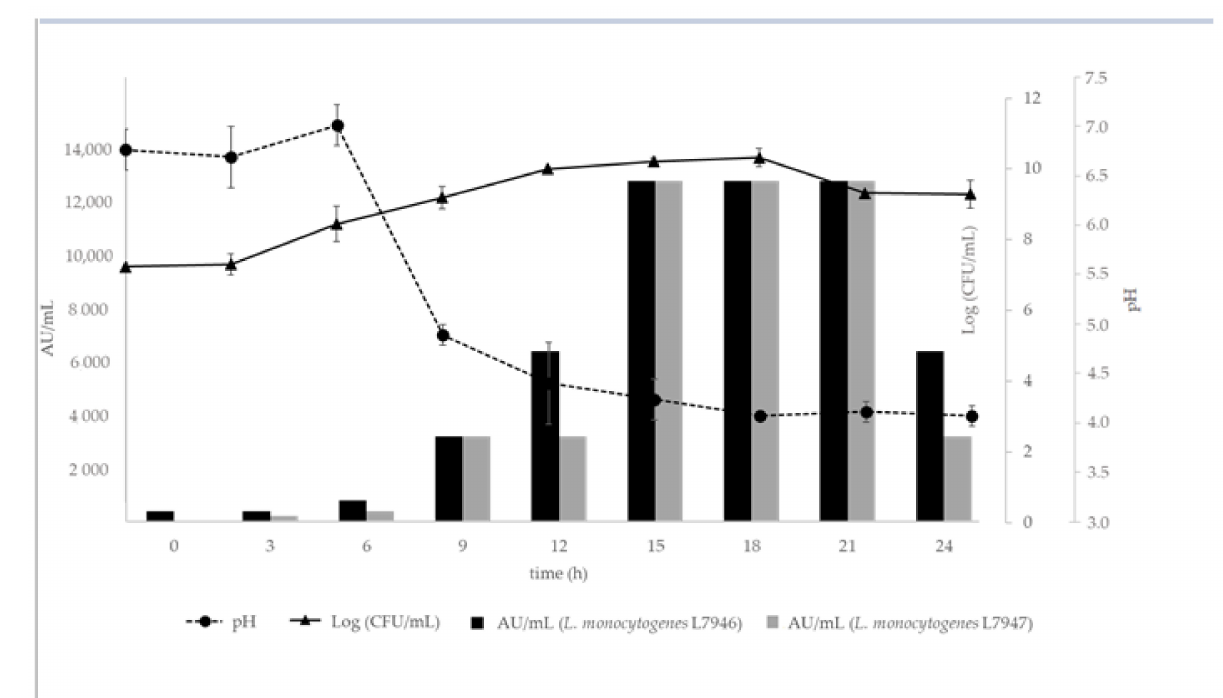
Figure 2. Production of bacteriocin(s) by Lpb. plantarum R23 in MRS broth (pH 6.4) at 30 ◦ C. The antimicrobial activity of cell-free supernatants is presented as AU/mL (bars) for L. monocytogenes L7946 and L7947 strains.